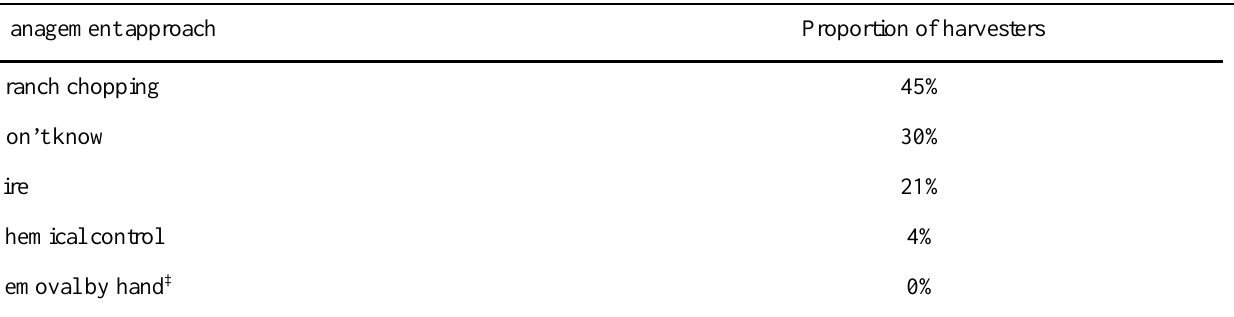
Table 3. Management responses advocated by amla harvesters.